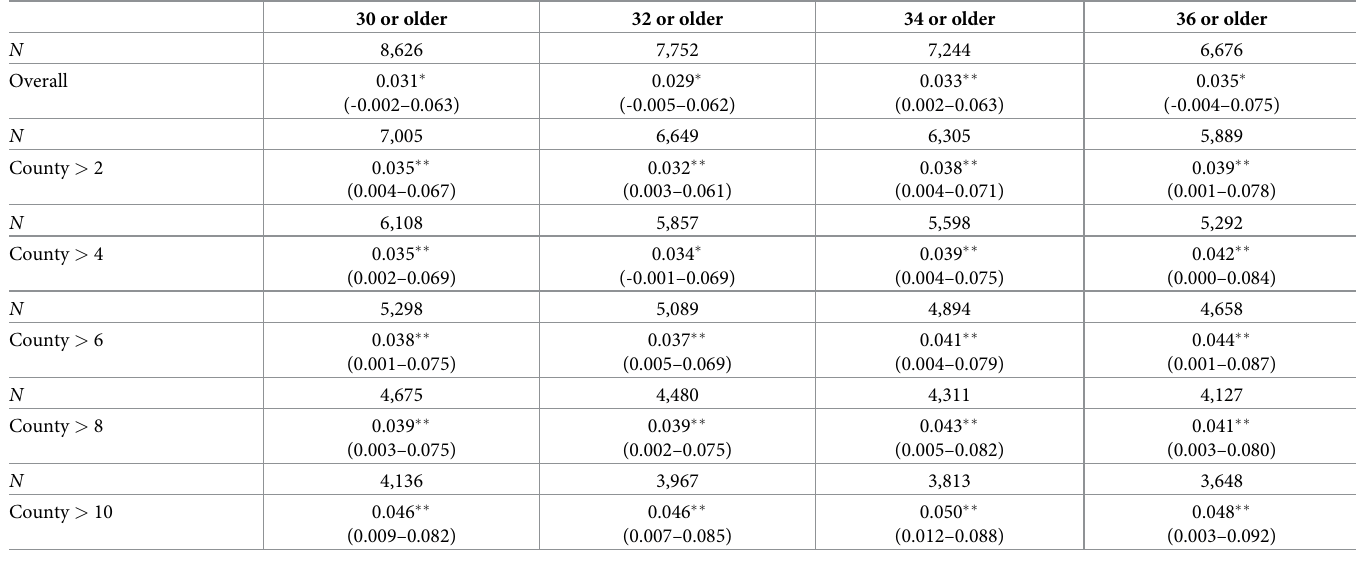
Table 2. The effects of neighborhood on health: Estimates of the percentage of the variation in adult self-rated health status attributable to county of